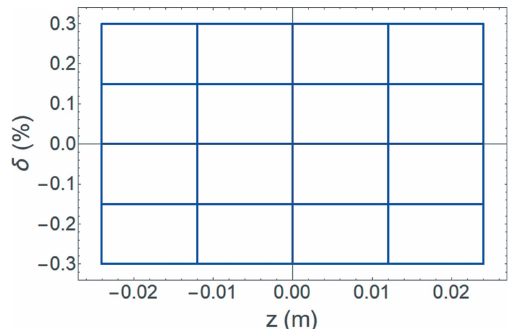
Figure 2 Longitudinal profiles of 100000 particles at the position of the crab cavity for examination of intrinsic resolution. Particles are distributed with a delta function in longitudinal phase space.